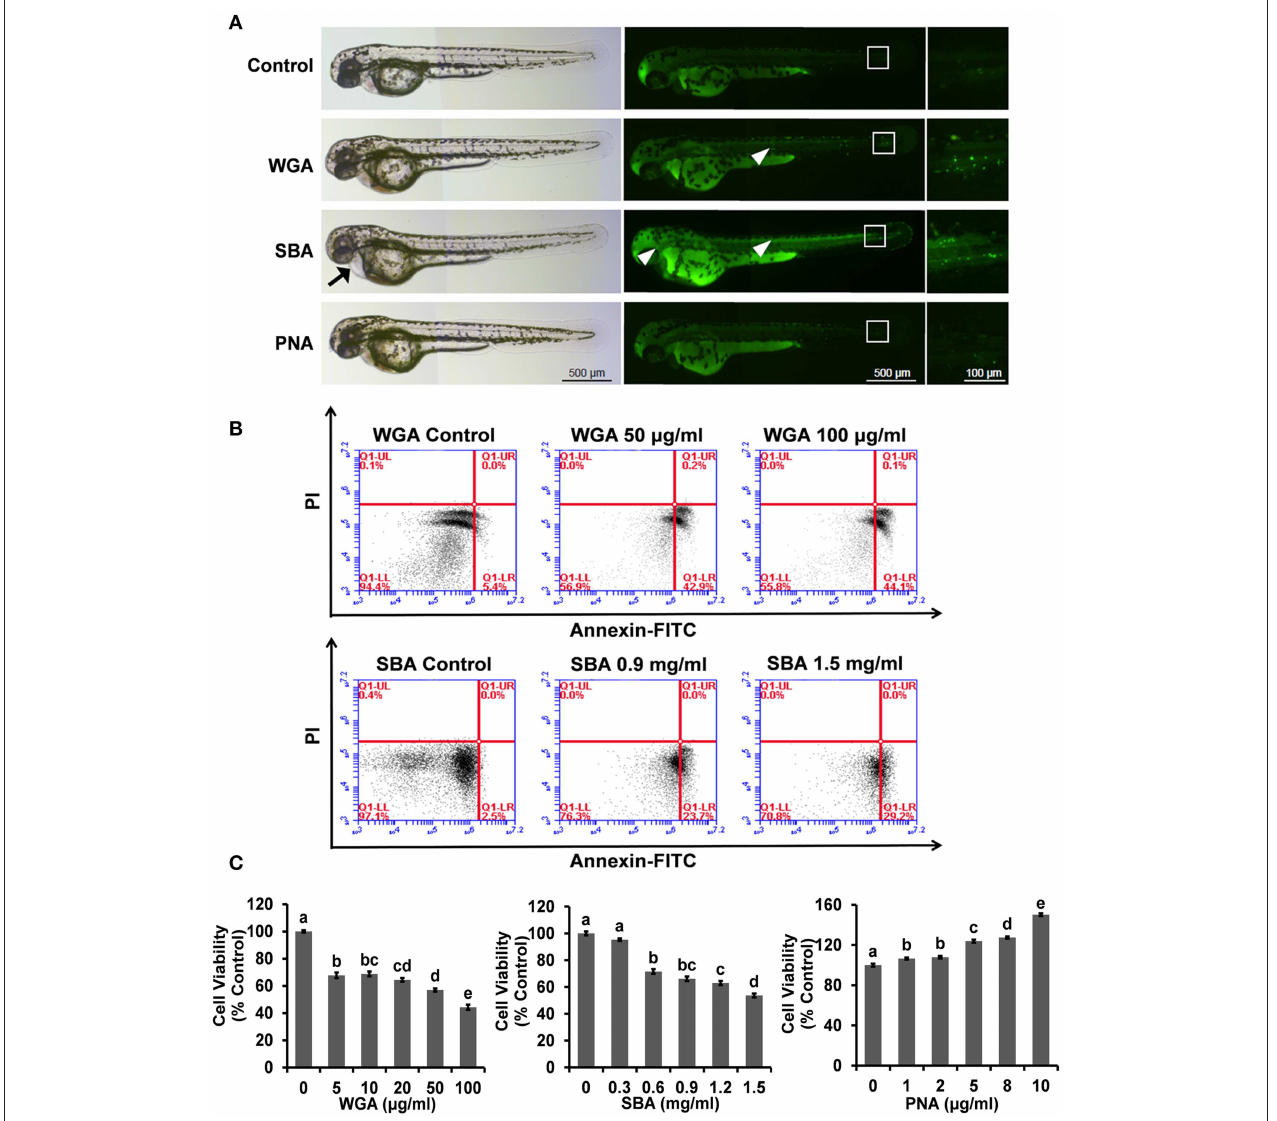
FIGURE 1 | The influence of lectins on the morphogenesis of zebrafish embryos and viability and proliferation in ZFL cells. (A) Zebrafish embryos were treated with indicated lectins at 4 hpf. At 48 hpf, larvae were stained with AO to visualize apoptotic cells which identified as green punctate dots. Arrow indicated the pericardial edema. The boxed region indicated the tail of embryos and the magnification views were shown on the right panel. The arrowhead indicated apoptotic cells in the head and trunk region. Scale bar, 100 and 500 µ m. (B) Cells were treated with WGA or SBA for 9h and stained with Annexin V-FITC/PI for apoptosis analyses using flow cytometry. (C) Cells were treated with series concentrations of WGA or SBA for 9h. Serum starved cells were treated with indicated concentrations of PNA for 48h. Cell viability was evaluated by the MTT assay. Results were represented as means with standard errors ( n = 6) and analyzed using One-Way ANOVA. Values with different letters in the same column (a–e) were significantly different ( p < 0.05) from each other.